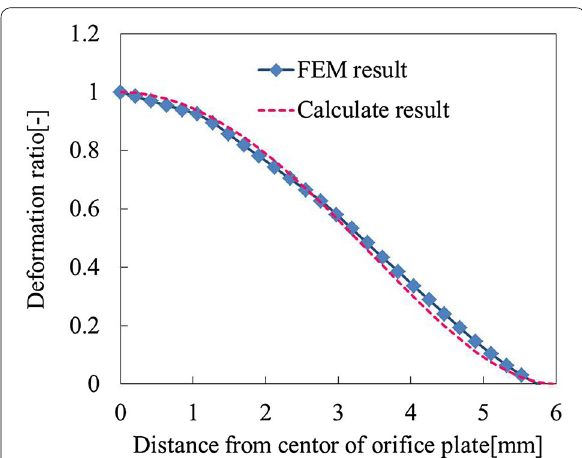
Fig. 7 Comparison of calculated and FEM results of deformation ratio